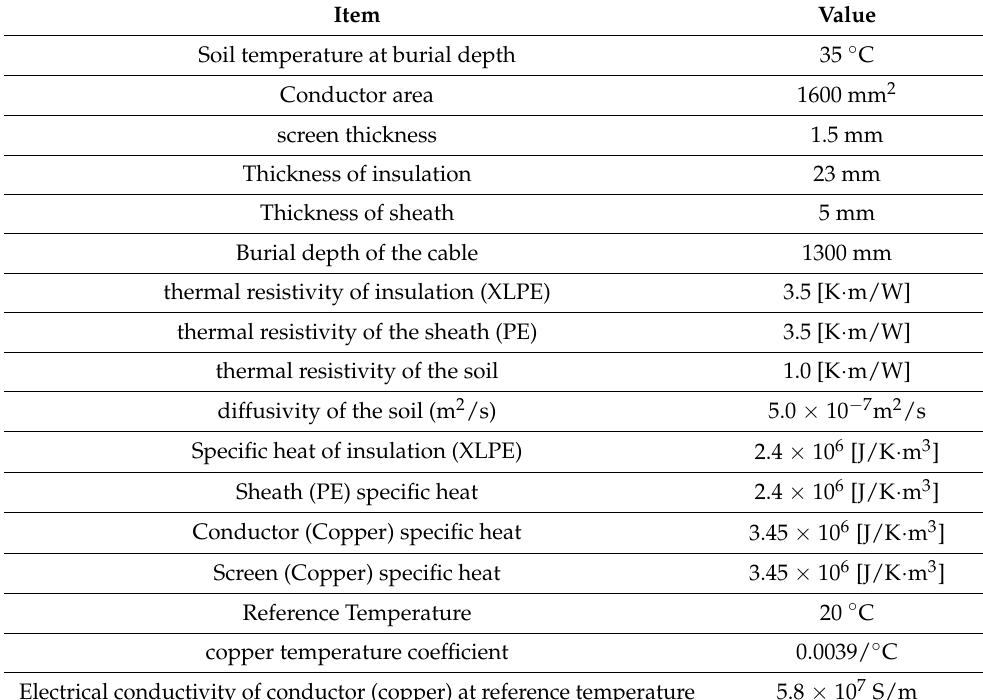
Table 1. Input data for cable dimension, soil properties, and temperatures.